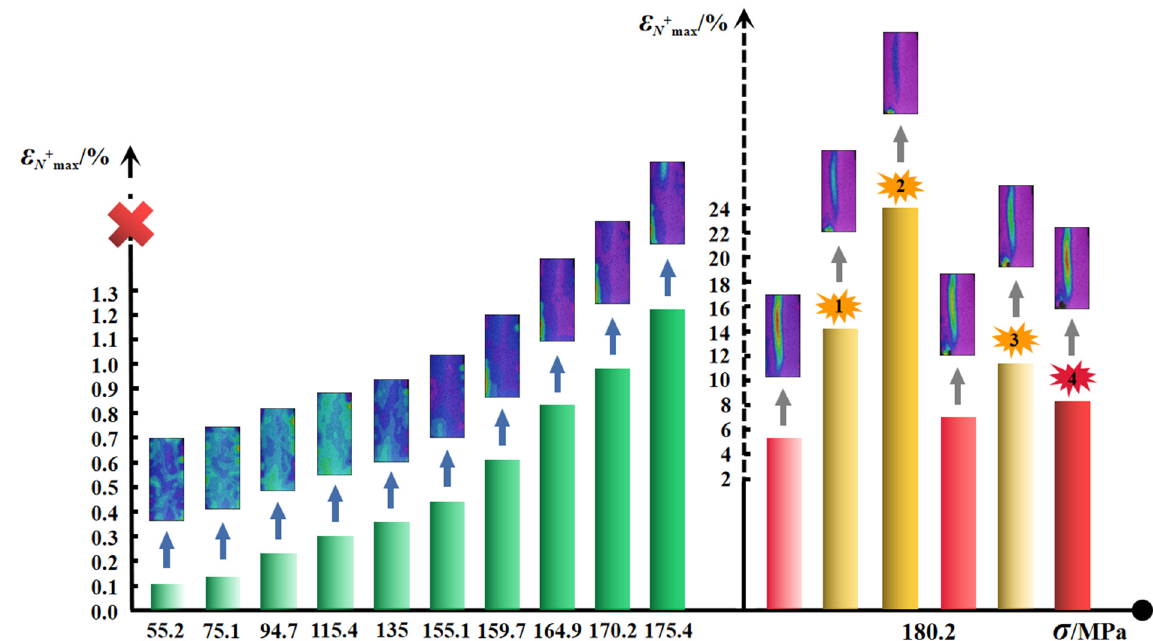
Figure 8. Positive maximum of net strain with stress level for granite.